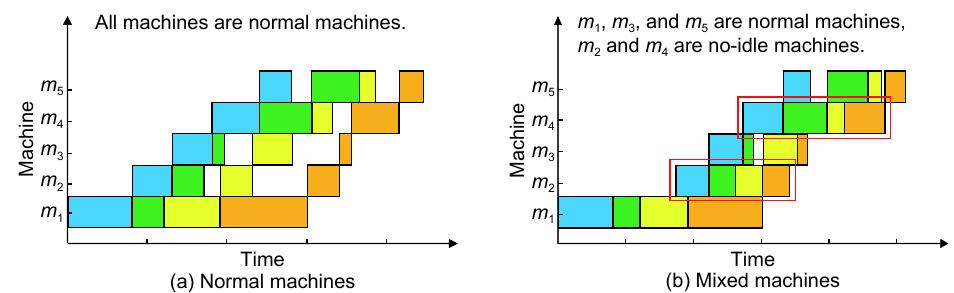
Fig. 2 Decoding method of MNIFSPs and the difference between decoding with normal machines.